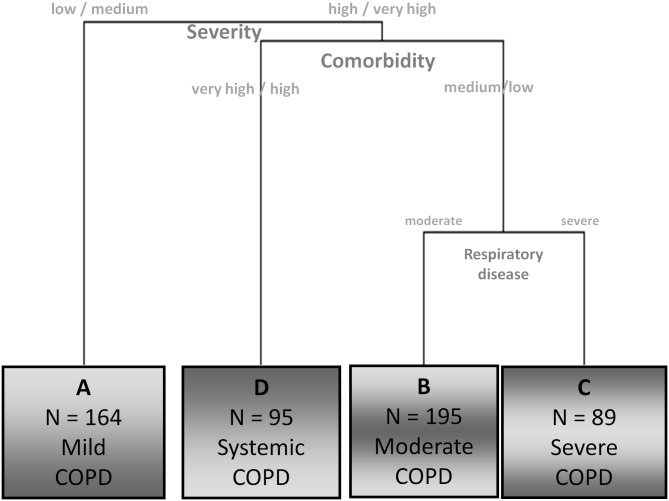
Partial dendrogram obtained from the cluster analysis.The dendogram represents the results from the cluster analysis performed with the four components obtained from the multiple correspondence analysis. The graphical display includes an easy interpretation of the partition and a brief description of the resulting clusters.